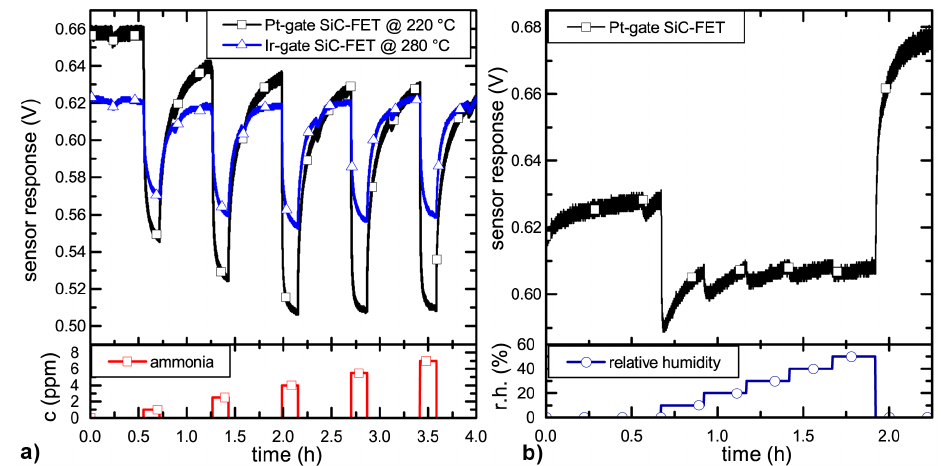
Figure 7. (a) Reference measurements of a Pt-gate SiC-FETs at 220 ◦ C and Ir-gate SiC-FET at 280 ◦ C to different concentrations c (1, 2.5, 4, 5.5 and 7ppm) of ammonia under dry conditions. (b) Influence of relative humidity RH.